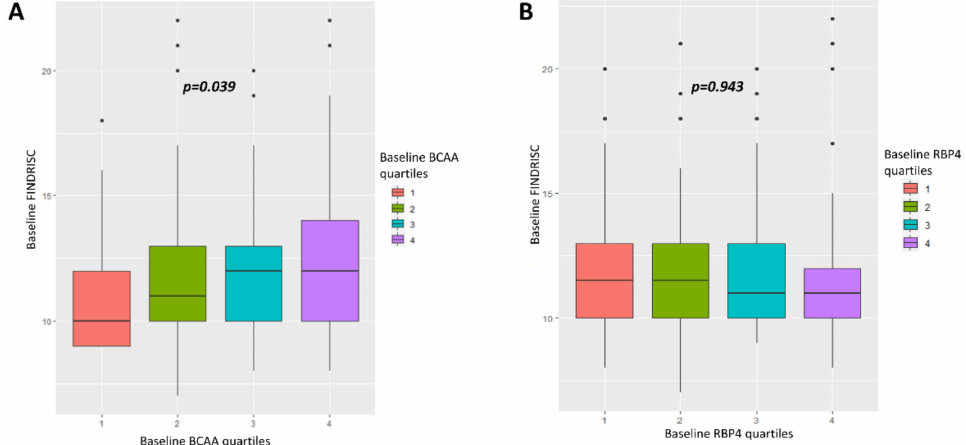
Figure 3. Association between baseline FINDRISC and baseline BCAA and RBP4 levels. BCAA: branched amino acid. RBP4: retinol-binding protein 4. The p -value, which compares baseline FINDRISC according to baseline BCAA quartiles ( A ) or baseline RBP4 quartiles ( B ), was calculated